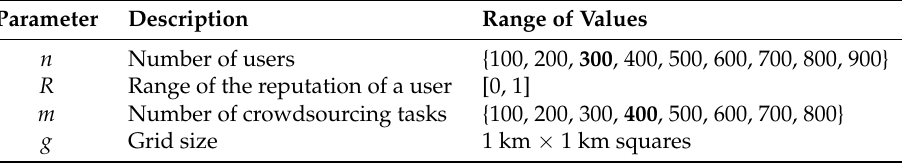
Table 4. The synthetic data parameters and their values.